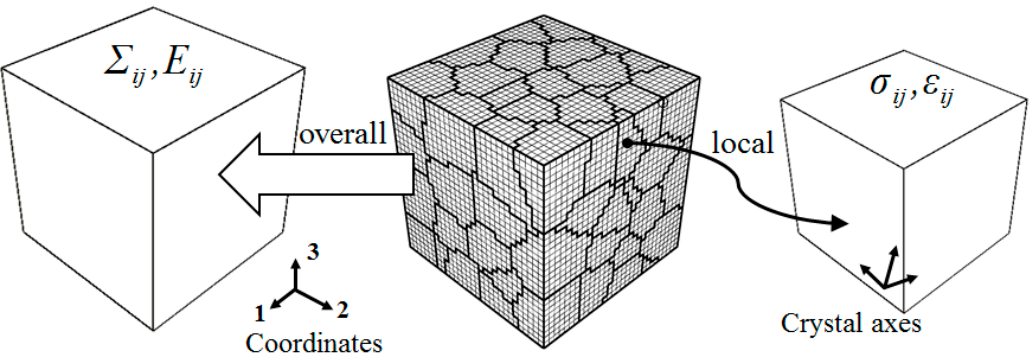
Figure 1. Local and overall stresses and strains of the RVE.